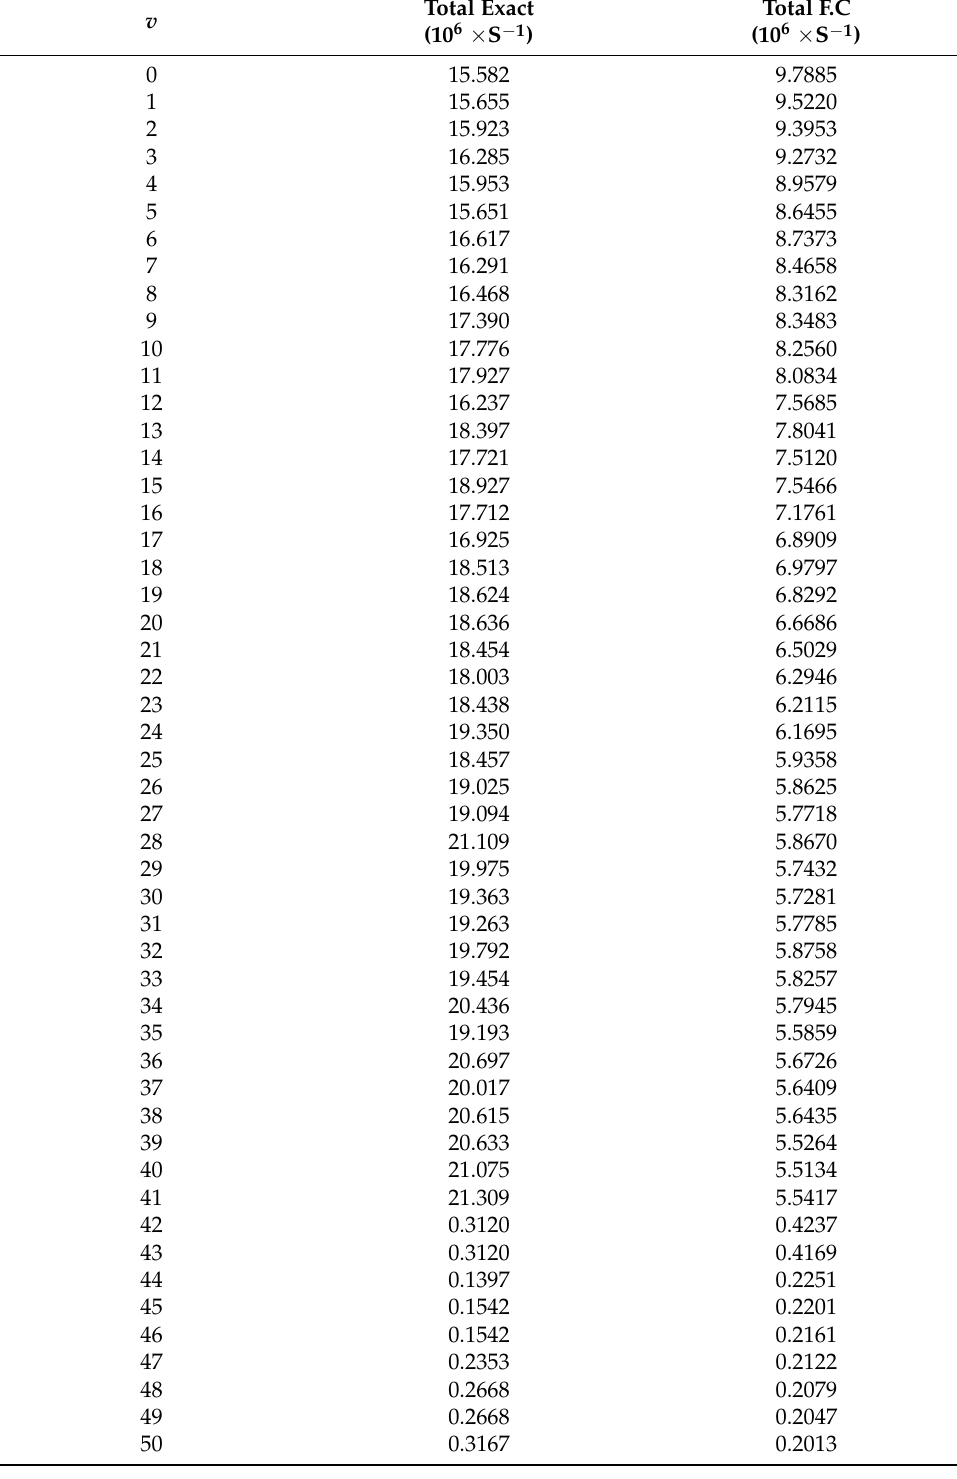
Table 5. Total radiative lifetime of the C-state of the ion (SrK) +